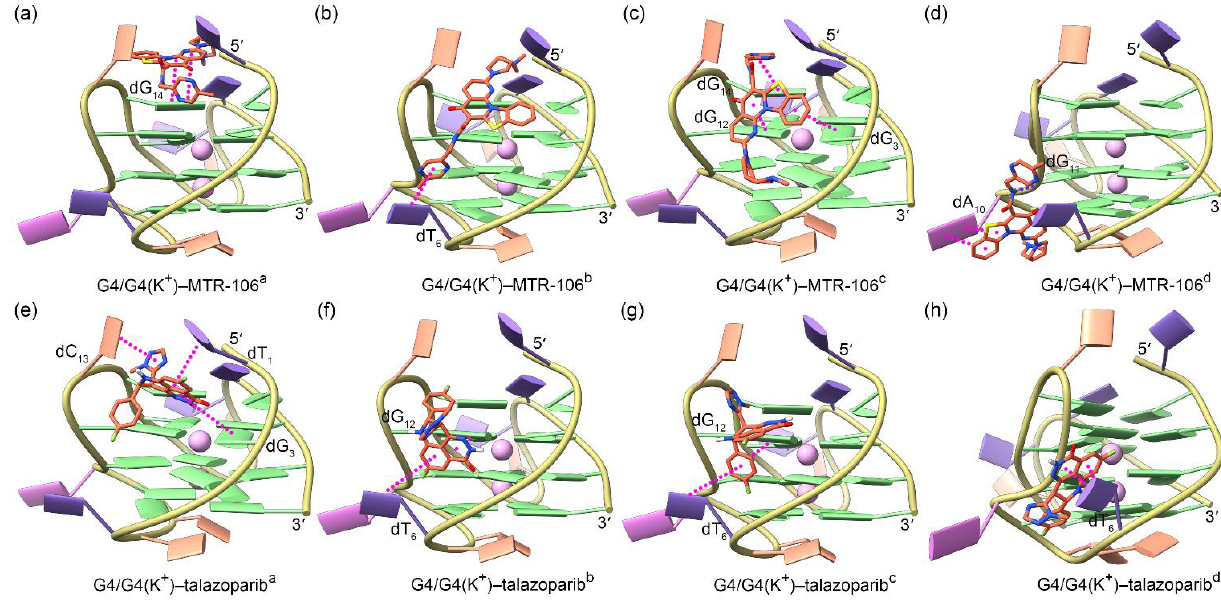
Figure 3. Binding conformations of PARP1 G4/G4(K + ) and the ligands of MTR-106 ( a – d ) and talazoparib ( e – h ) derived from molecular-docking calculations. The central K + ions are shown as faded-pink spheres to indicate their negligible effect on the binding conformations of both ligands. The π – π -stacking and hydrogen-bond interactions between G4/G4(K + ) and the binding ligands are represented as magenta and blue dotted lines, respectively. Table 1. Interactions of MTR-106 and talazoparib with PARP1 G4 based on molecular docking.